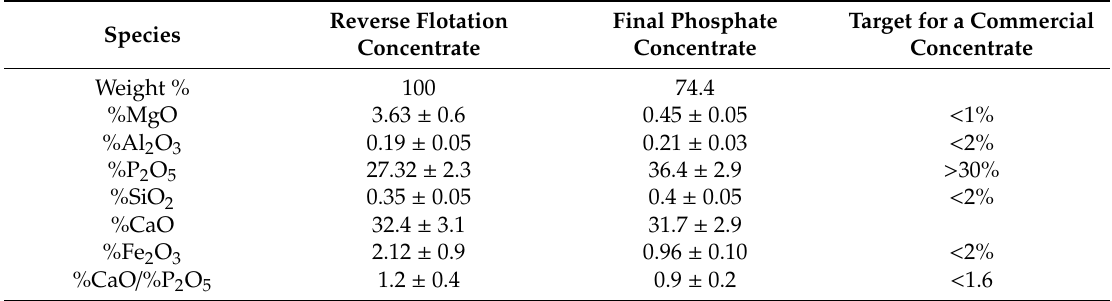
Table 8. Results of leaching tests with 60 min leaching at pH 3.0 ratio S/L 1/9 (average ± standard deviation of the results of 3 leaching tests).